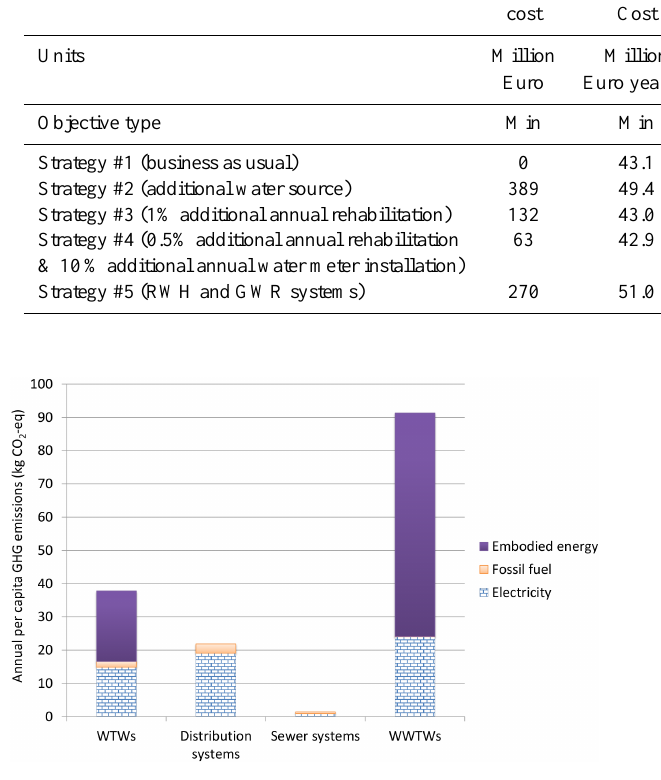
Figure 5. Annual average of per capita GHG emission for interven- tion